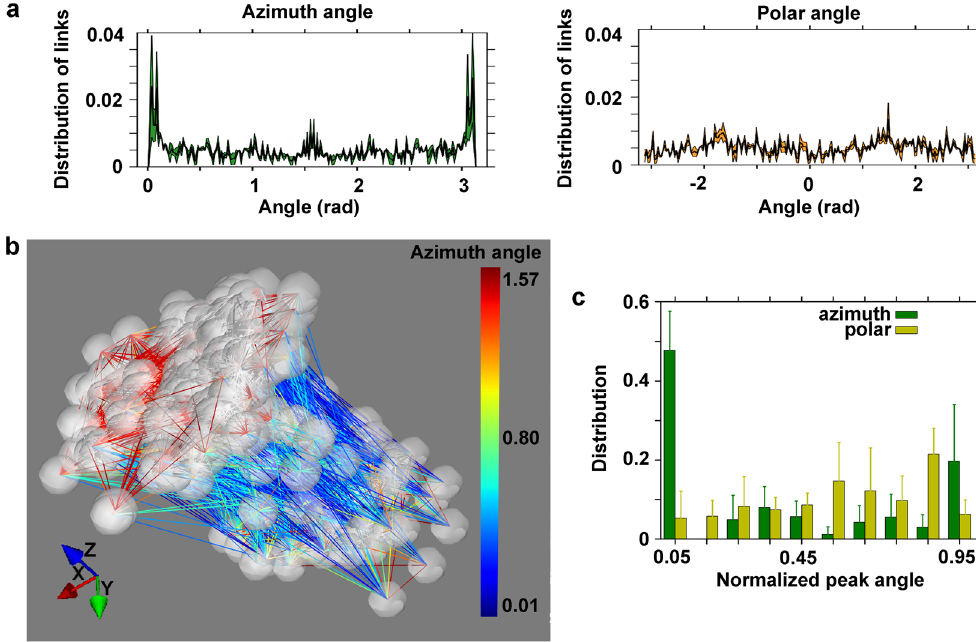
Figure 7. Properties of the functional graph. ( a ) The azimuth (left panel) angle of the detected functional links of a cortical neuronal network (32 DIVs) has a peak at 0, π (i.e. along the z-axis, the vertical axis) and at π /2 radian. The corresponding polar (right panel) angle fluctuates around the value 0.005. ( b ) Illustrative plot of the 3D cell culture at 32 DIVs of panel a), showing the predominance of vertical links (blue) with the coexistence of horizontal links (red). The vertical links (blue) correspond to the peaks of the azimuth angle at 0 and π radians. The horizontal links (red) correspond to the peak at π /2 radians. Note that the dimensions of the plot are not to scale and have been stretched to evidence the orientation of the links in the network, and all the recorded cells of the network on the entire volume view of the optical system (800 × 800 × 300 µ m) are reported. ( c ) The vertical orientation is a general feature of the studied 3D cortical single-cultures. Population summary histogram of the distribution of normalized polar and azimuth orientation angles of the detected neuronal links. Data shown are the mean values + standard errors (the groups consisted of 20, 22 24 and 13 cell cultures,